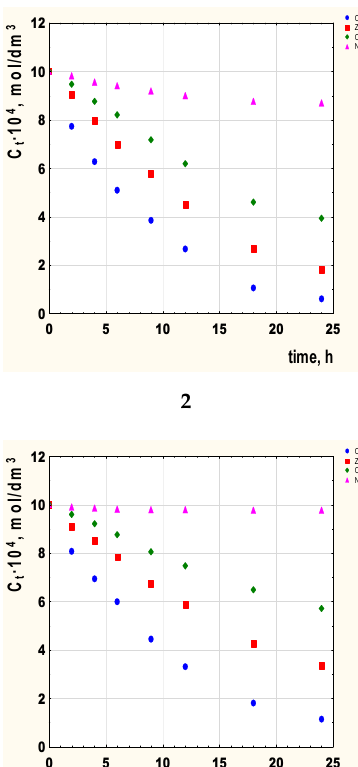
Table 2. Average thickness and roughness of PIMs.